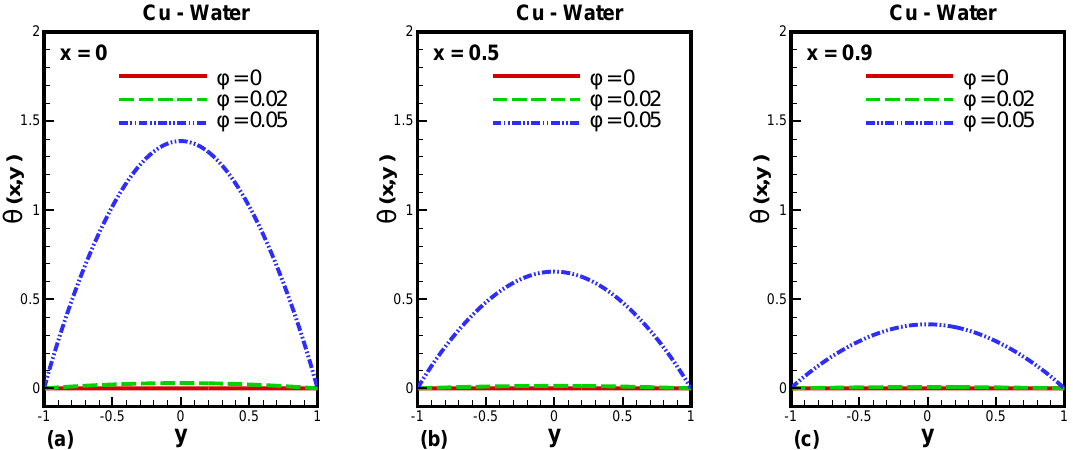
Figure 4. Effect of copper nanoparticle volume fraction φ on dimensionless temperature at the ( a ) entrance, ( b ) middle, and ( c ) exit regions of the channel, when β = 0.5, B r = 6, P e = 1, δ = 0.2, R e = 1, and γ = 0.2. The variations in the wall shear stress and the heat transfer rate with the governing parameter φ are presented in Figure 5a,b. Figure 5a shows that when increasing the strength of φ , the wall shear stress decreases, see Figure 5a. Furthermore, it is noted that its profile decreases along the channel due to the reason of fluid leakage across the walls of the channel. Figure 5b shows that the heat transfer rate also declines along the channel from entrance to exit; with increasing φ , its profile increases. Maximum heat transfer rate is noticed at the entrance of the